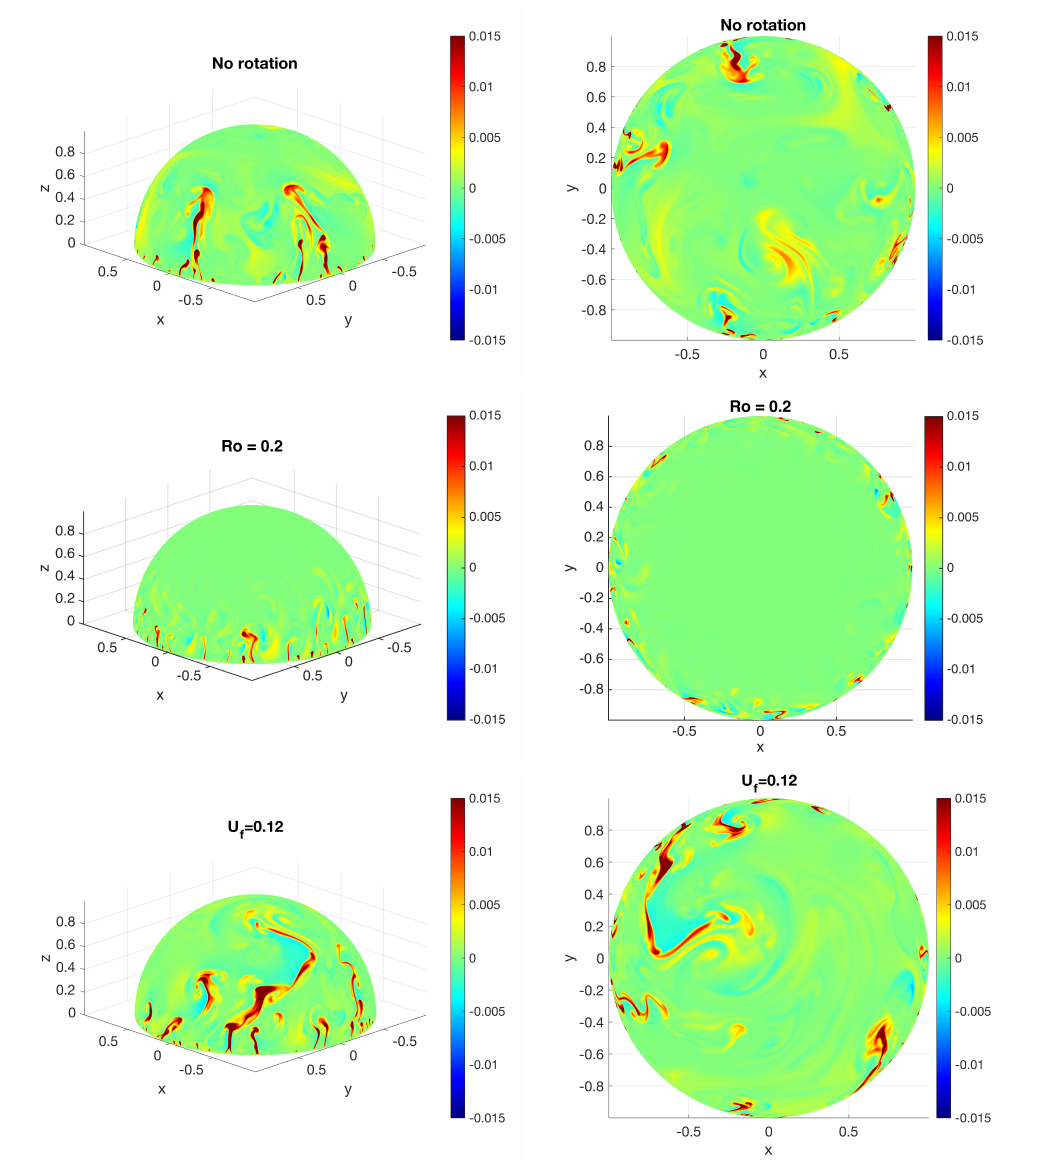
Figure 6. Convective heat flux fields. Top: No-rotation case. Middle: Method 1 with Ro = 0.2. Bottom: Method 2 with U f = 0.12. Left: Side view. Right: North pole